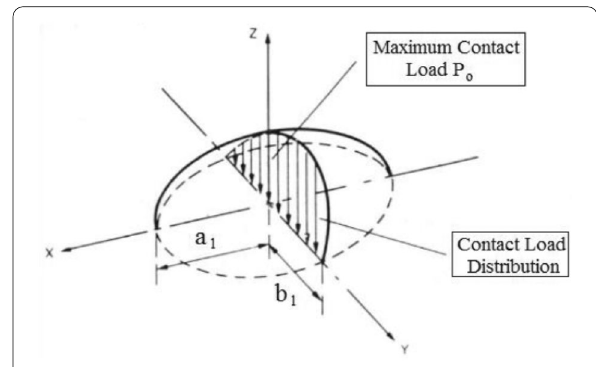
Figure 10 Contact load distribution between two curved bodies [24]